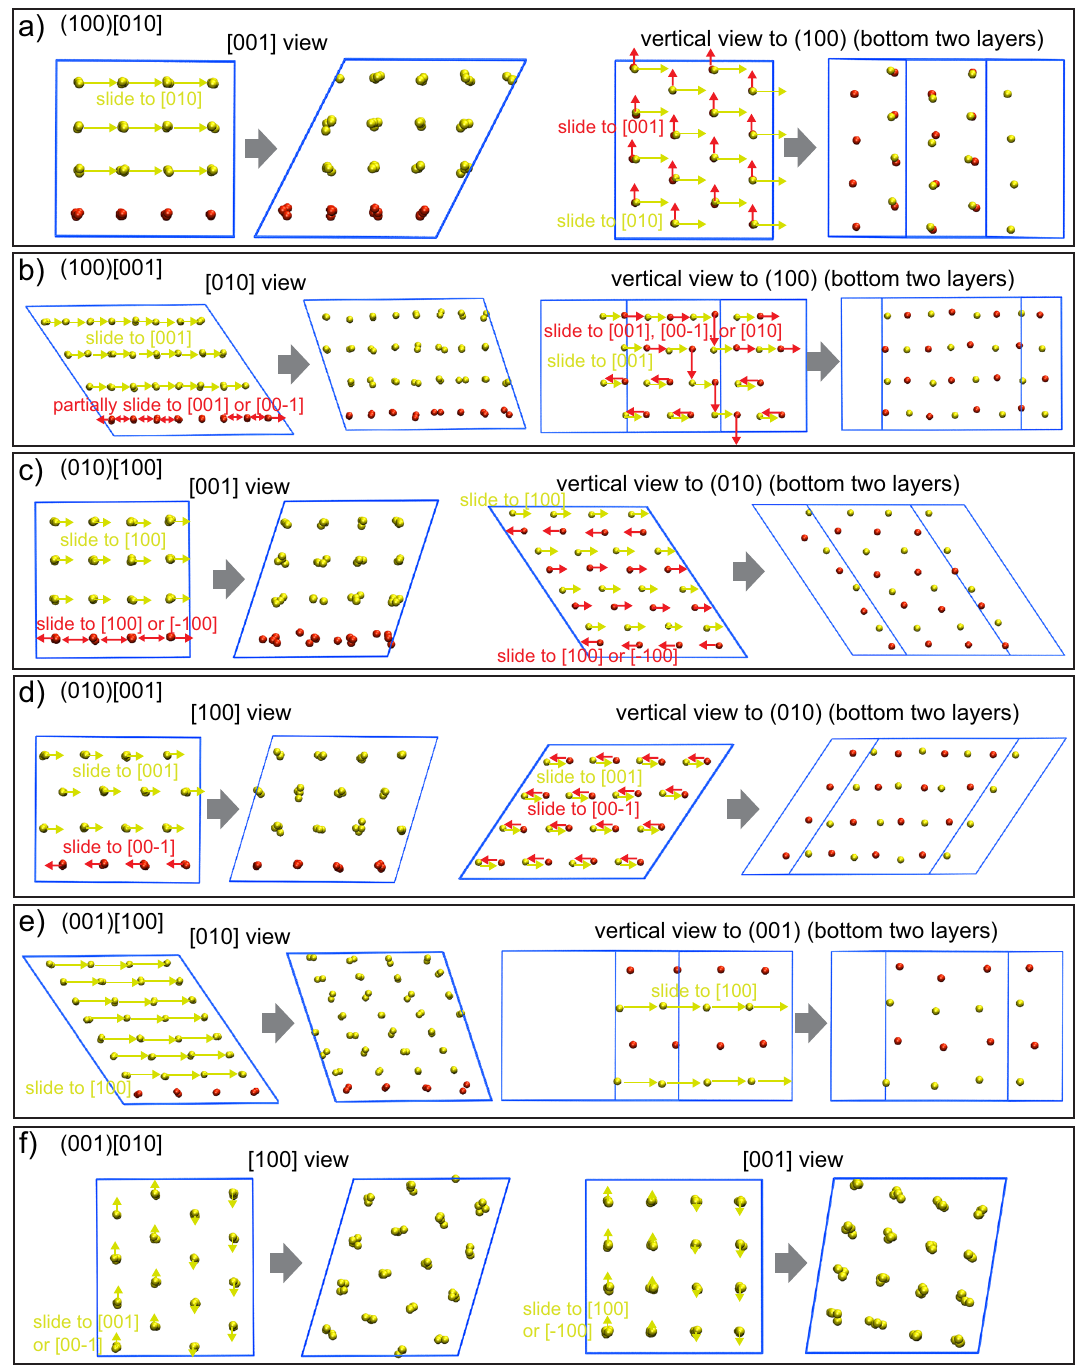
Figure 4. Structural behaviors of m-Ag 2 S under shear deformations. The initial (left side of the gray arrow) and recovered (right side of the gray arrow) atomic configuration in ( a ) (100)[010], ( b ) (100)[001], ( c ) (010)[100], ( d ) (010)[001], ( e ) (001)[100], and ( f ) (001)[010] shear system. The left half shows view from the direction that parallel to the shear plane and perpendicular to the shear direction, and the right half shows view from another direction. Both yellow and red balls indicate sulfur atoms but are classified by their